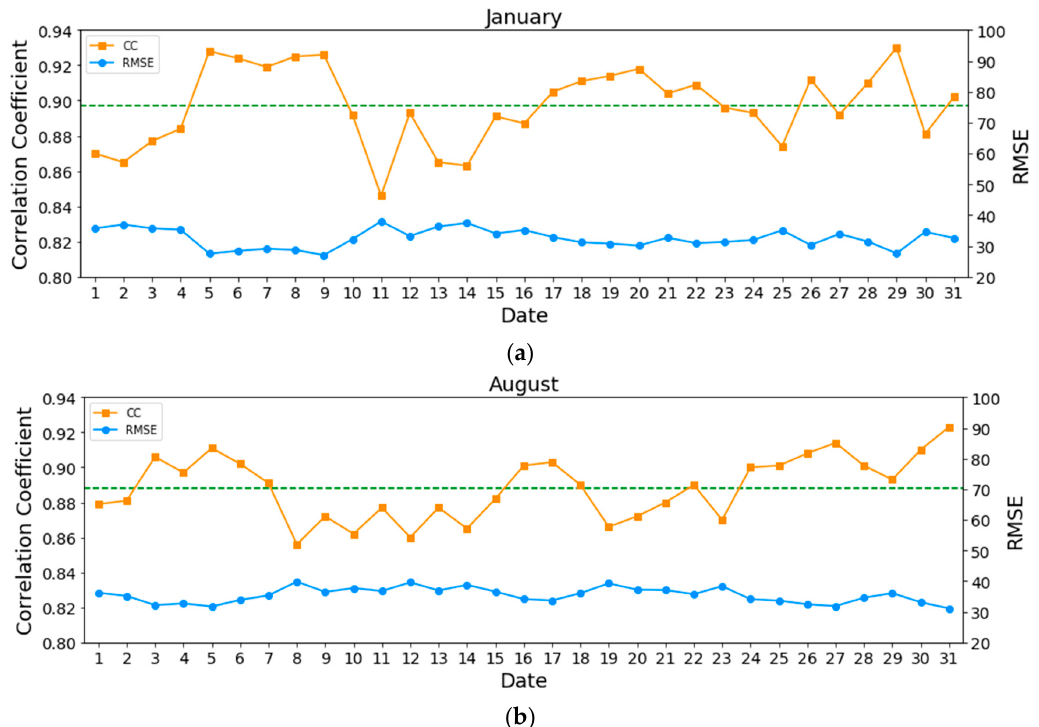
Figure 7. Time series of CC and RMSE between real VIS reflectance and AI-generated reflectance (daytime) during (a) winter (January 2018) and (b) summer (August 2018). Figure 8a,b show the real VIS observation and AI-generated VIS reflectance images during the nighttime (October 22, 2018, 17:00 UTC (October 23, 02:00 KST), respectively. At this time, there is no real COMS VIS reflectance because there is no sunlight. Otherwise, our AI-generated VIS nighttime reflectance image would show the characteristics of clouds from the real daytime VIS reflectance.